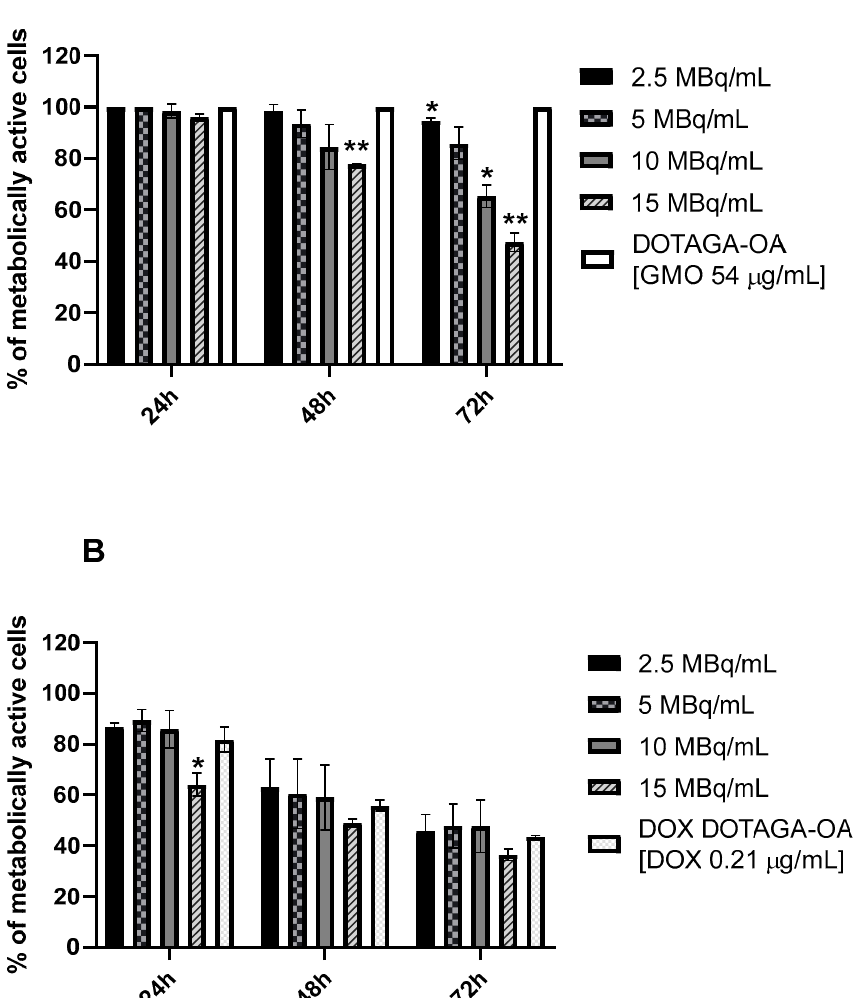
Figure 5. Viability of HeLa cells treated with cubosomes doped with: ( A ) DOTAGA-OA- 177 Lu and ( B ) DOX DOTAGA-OA- 177 Lu. DOTAGA-OA and DOX DOTAGA-OA cubosomes were used as a control. Data points and SD are taken from three or more measurements. Statistical significance was considered if p ≤ 0.05 (*) and p ≤ 0.01 (**).